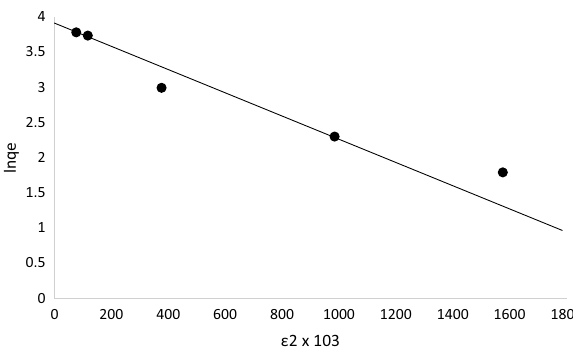
Fig. 9 Langmuir adsorption isothermal plot for the adsorption of Rh-B on AgNPs